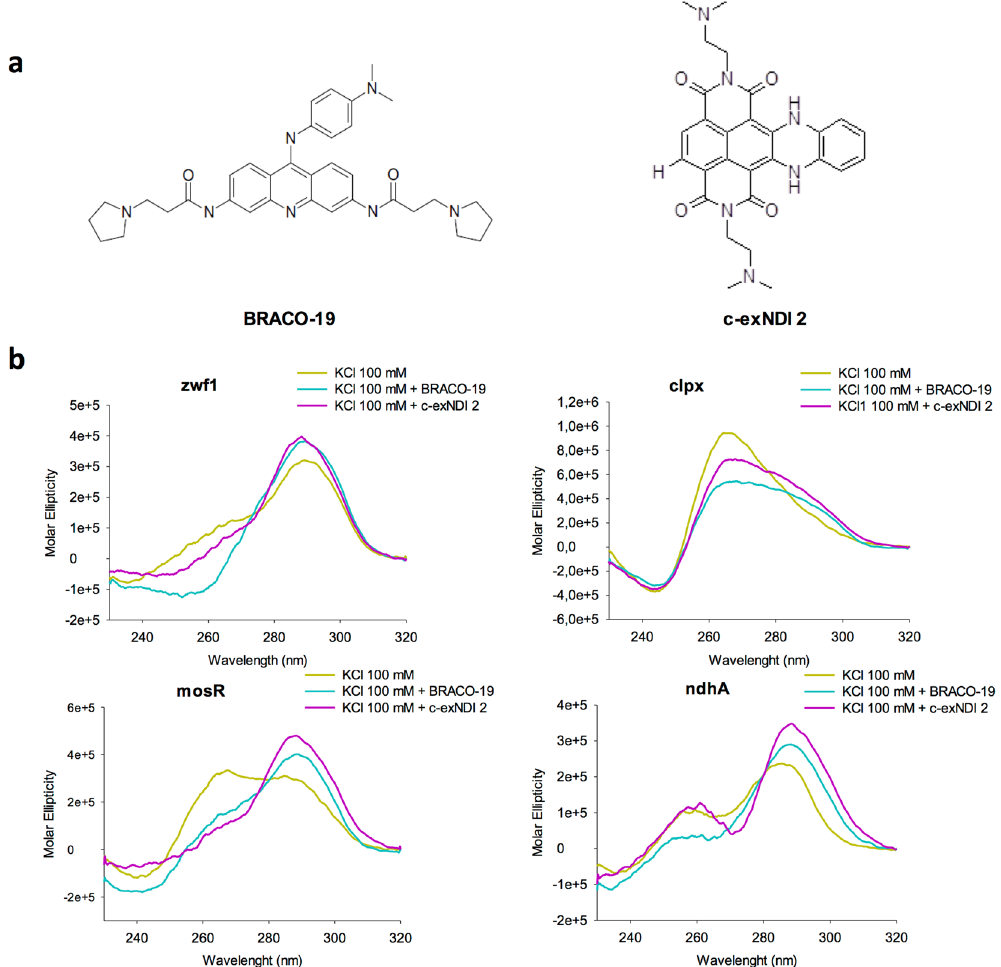
Figure 2. Effect of the G4 ligands BRACO-19 and c-exNDI 2 on the conformation of the selected Mtb G4s. ( a ) Chemical structures of the G4 ligands BRACO-19 and c-exNDI 2. ( b ) CD spectra of G4 oligonucleotides zwf1 , clpx , mosR and ndhA (final concertation 4 μ M) in the presence of KCl (100 mM) and BRACO-19 or c-exNDI 2 (final concentration 16 μ M) to assess G4 topology changes. The molar ratio oligonucleotide:compound was